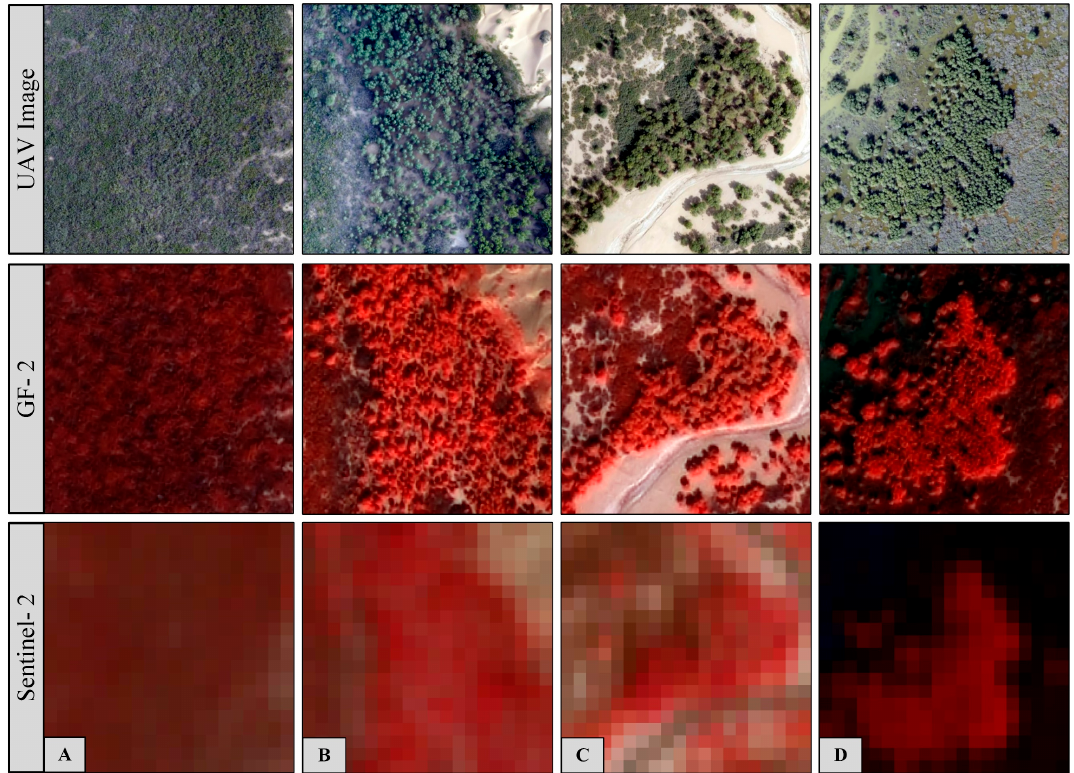
Figure 2. Typical plant distribution patterns of the study site in three spatial resolution images. The above plot area is 200 × 200 m 2 . ( A ) Dense distribution area of Tamarix chinensis , ( B ) dense distribution area of Populus euphratica , ( C ) mixed area of Populus euphratica and Tamarix chinensis , and ( D ) mixed area of Populus euphratica and Tamarix chinensis in the flood period.